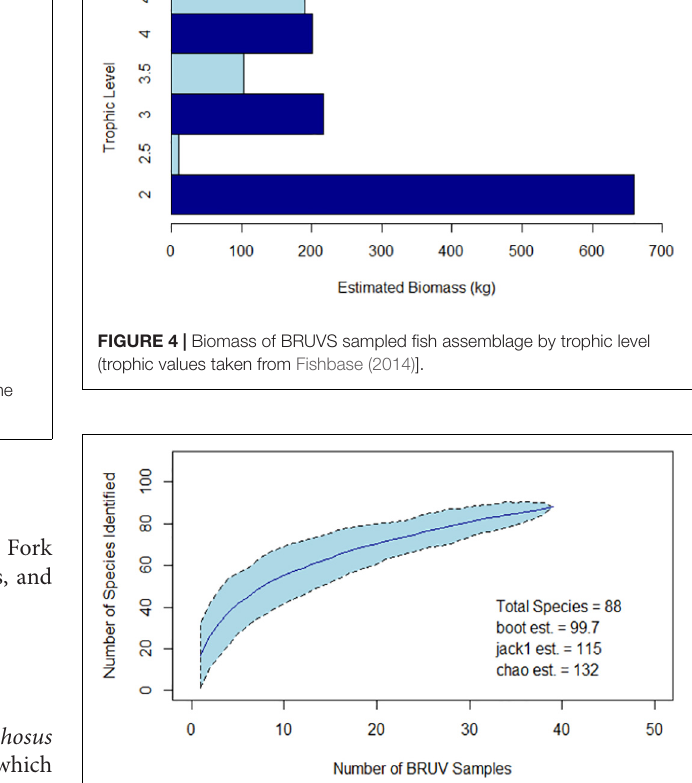
FIGURE 5 | Curve showing the accumulation of identified species during sampling (dark blue line). Confidence intervals are indicated by the light blue polygon and dotted lines. Values for estimated total species richness according to three indices are inset.